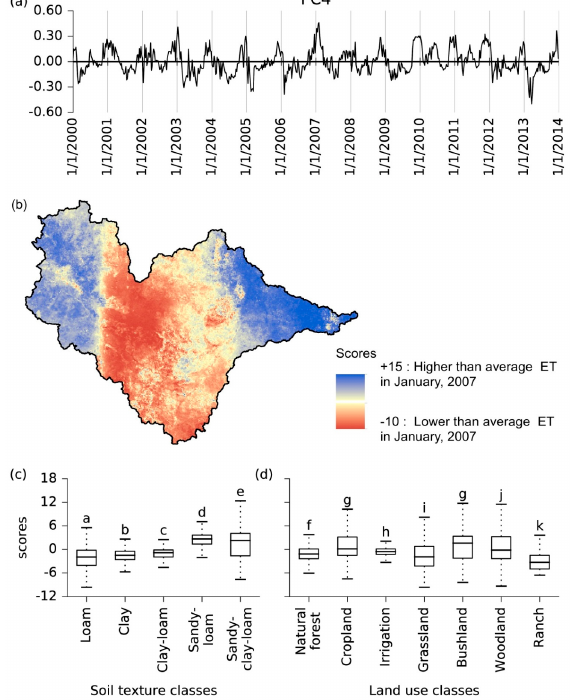
Figure 7. Time series of the loadings on the fourth principal component (PC4) ( a ). Map of the scores of PC4 ( b ). Quartiles of the scores of PC4 for different soil texture ( c ) and land use ( d ) classes, similar score distributions at the 5% level of significance are marked with the same small letter.